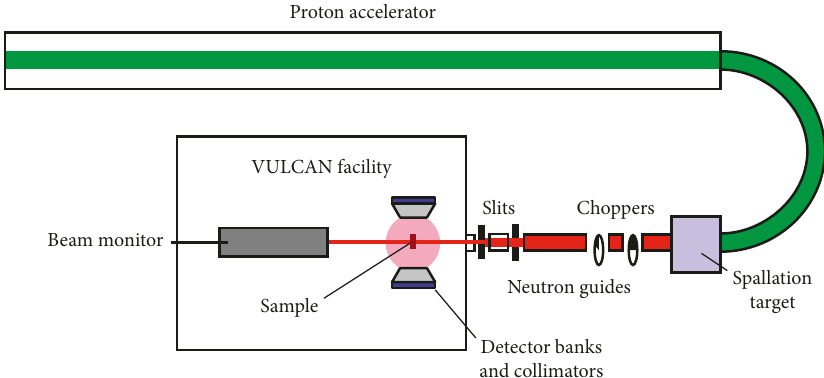
Figure 1: Schematic of the ORNL Spallation Neutron Source and VULCAN instrument facility. A proton beam knocks neutrons from atoms in the target, and these are pulsed at different frequencies by the choppers and guided to the sample where they are diffracted. Their time of flight determines their wavelength for Bragg scattering (see Figure 2 for details of the VULCAN diffractometer).